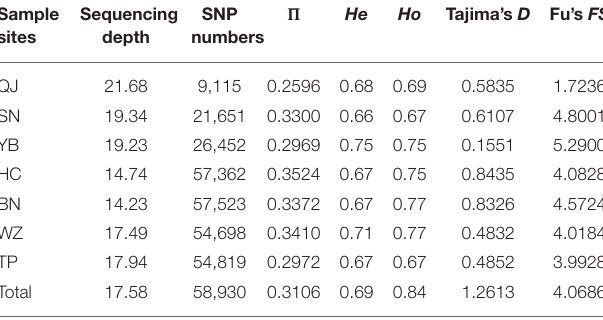
TABLE 2 | Genetic diversity parameters of Saurogobio dabryi . Sample